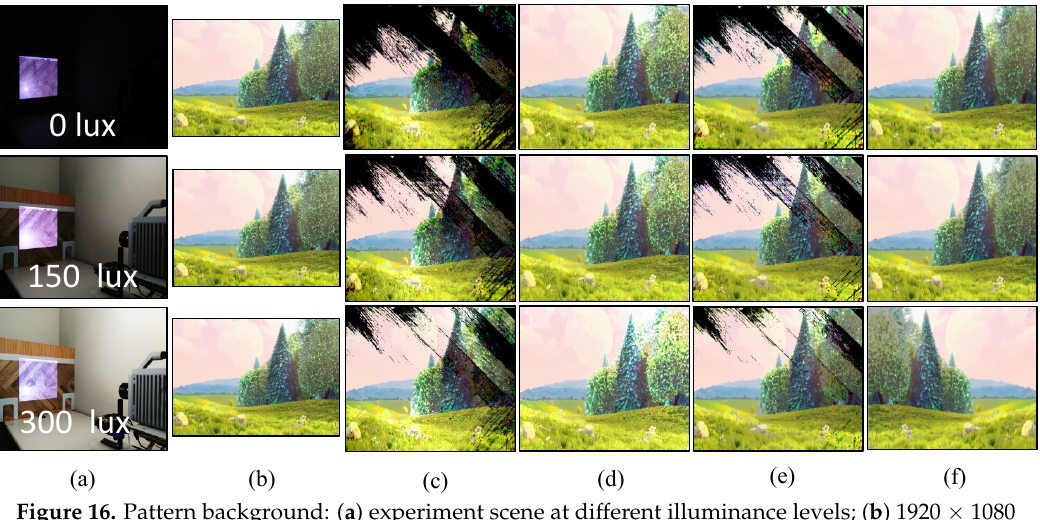
Figure 16. Pattern background: ( a ) experiment scene at different illuminance levels; ( b ) 1920 × 1080 input images; ( c ) 510 × 459 images reconstructed using pure-binary-code without background subtraction; ( d ) 510 × 459 reconstructed images with pure-binary-code with background subtraction; ( e ) 510 × 459 reconstructed images using gray-code without background subtraction; and ( f ) 510 × 459 reconstructed images using gray-code with background